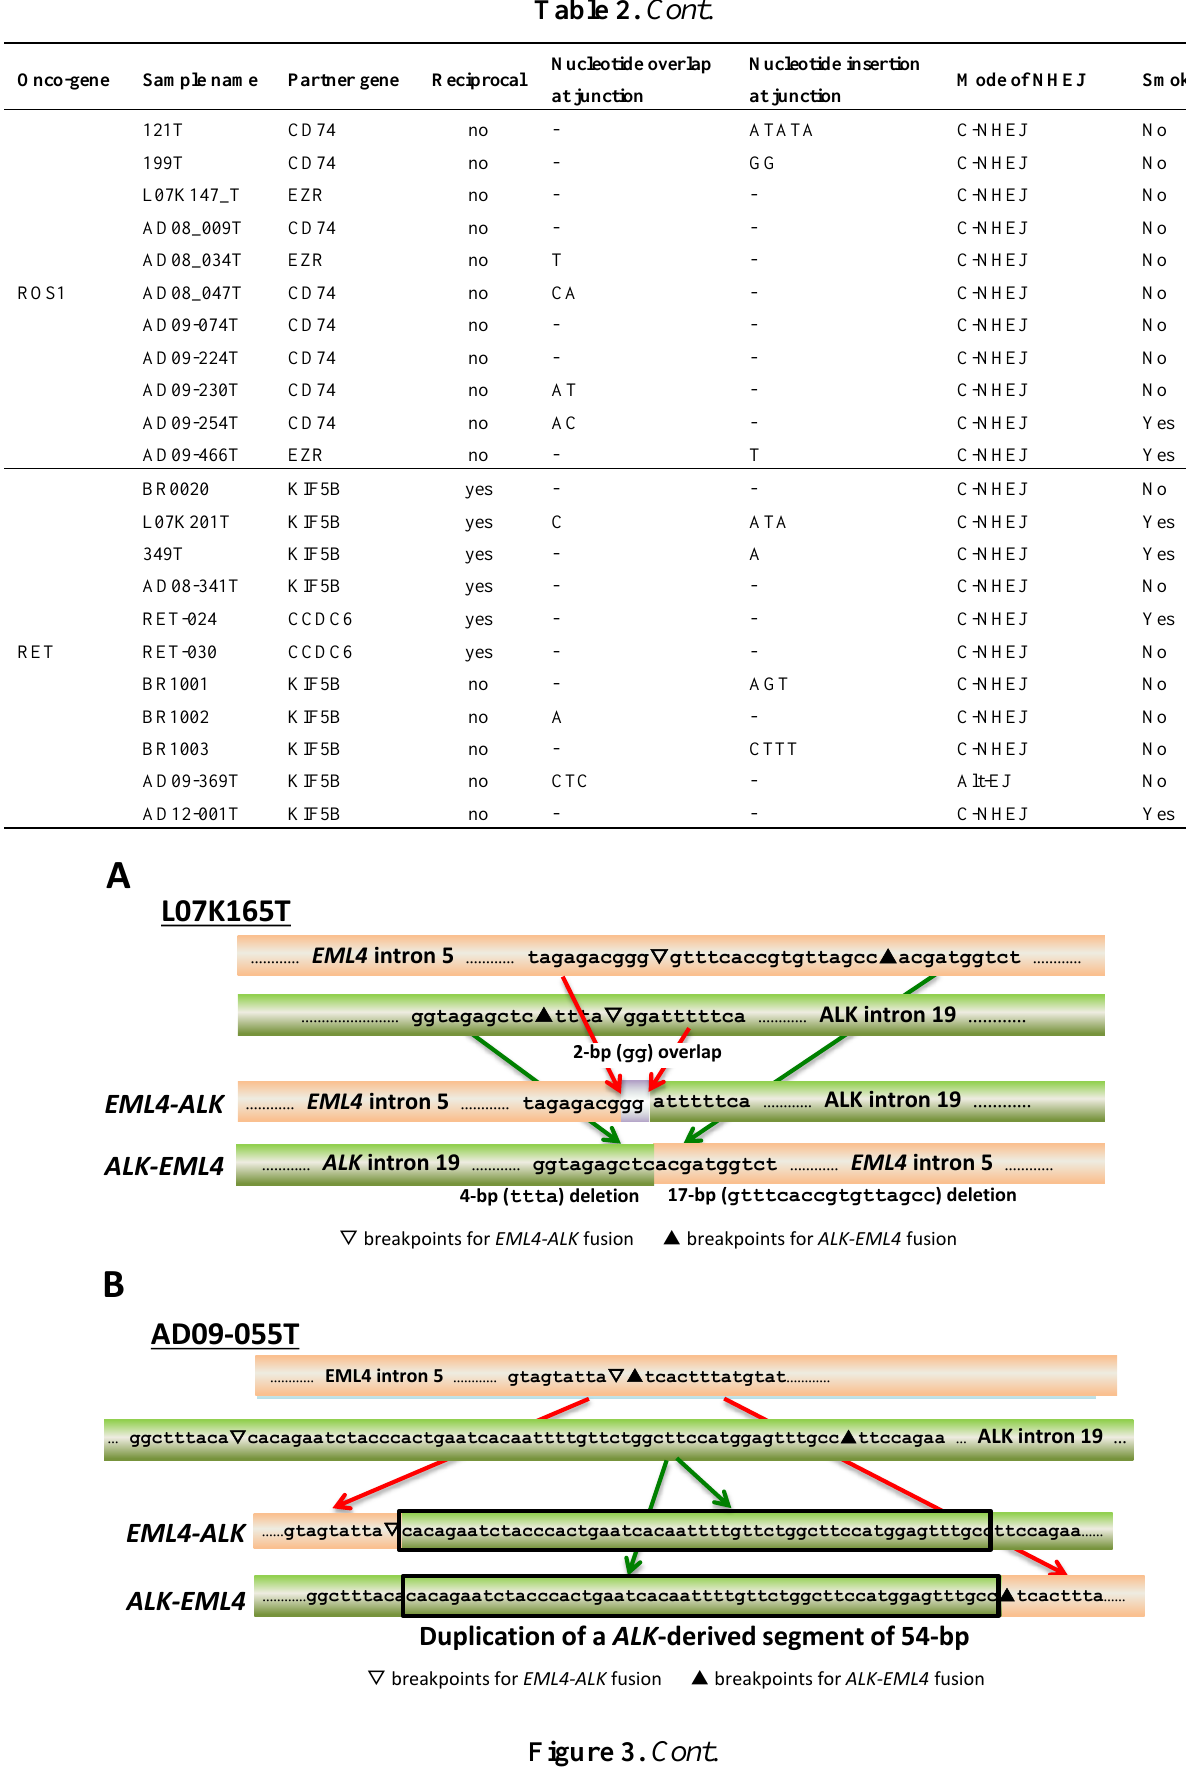
Figure 3. Cont . DSBs in breakpoint cluster